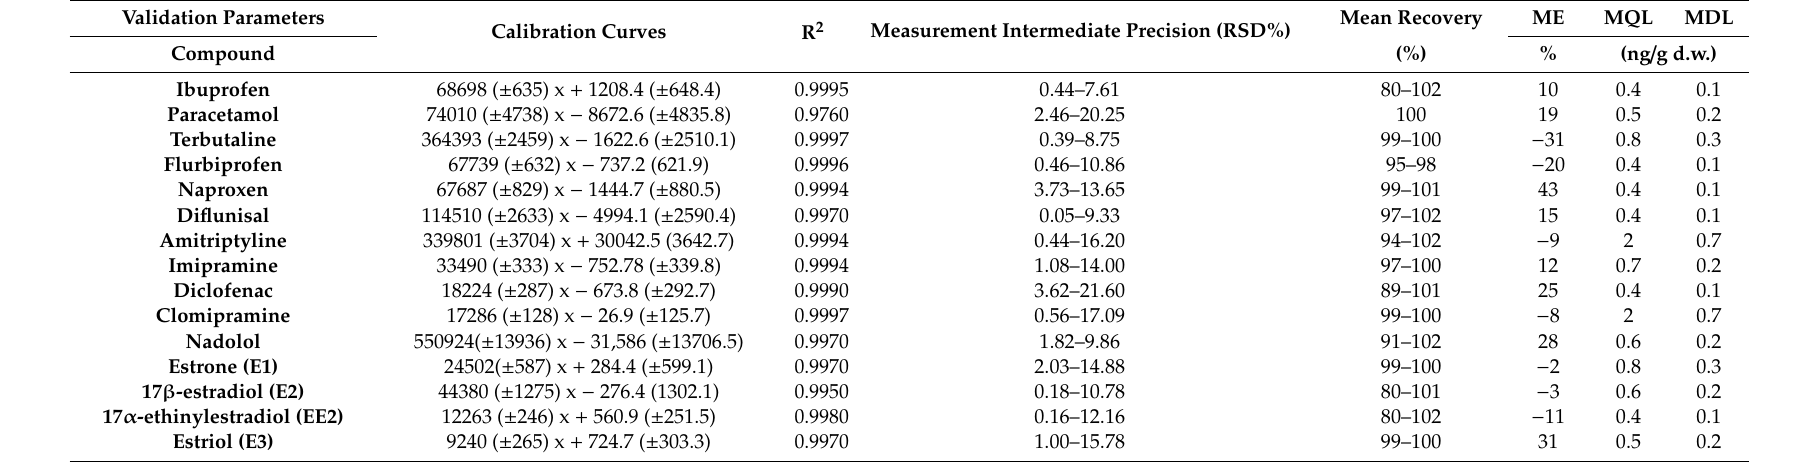
Table 3. Selected validation parameters of the ASE-SPE-GC-MS(SIM) method for determining target compounds in plant samples (analytical range from method quantification limit (MQL) to 2500 ng / g). Precision and accuracy were determined for three concentrations from analytical range (78 ng / g d.w., 625 ng / g d.w., and 2500 ng / g